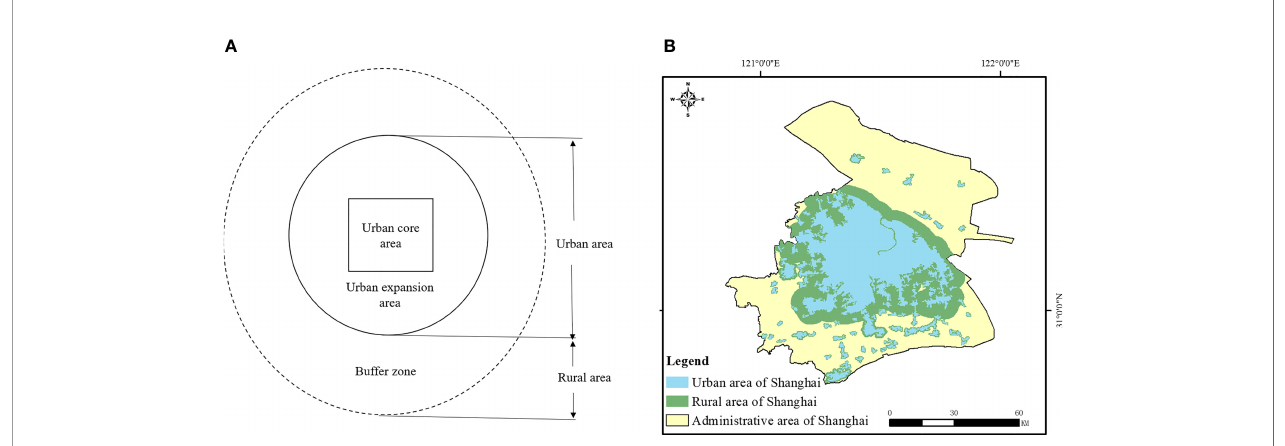
FIGURE 4 | Divisions of urban-rural gradient zones. (A) The diagrammatic drawing of divisions. (B) The divisions result